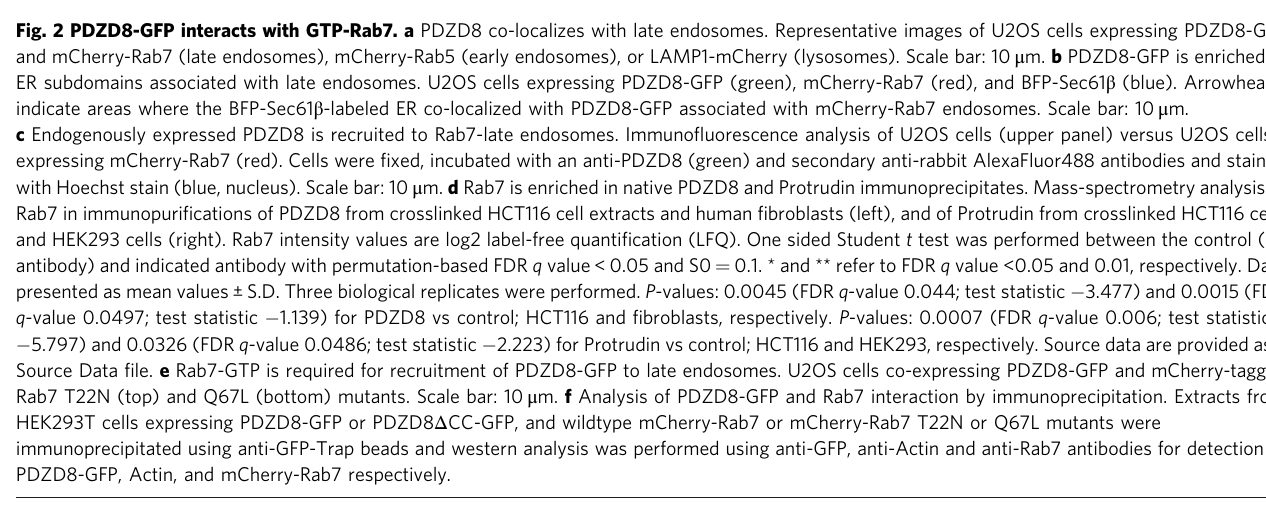
Fig. 2 PDZD8-GFP interacts with GTP-Rab7. a PDZD8 co-localizes with late endosomes. Representative images of U2OS cells expressing